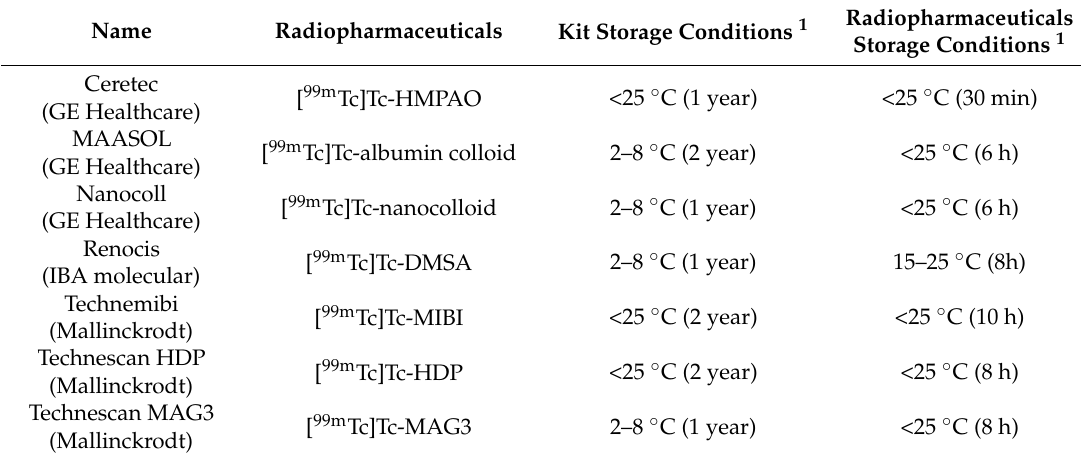
Table 1. Freeze-dried kits analyzed and the temperature required by the manufacturer for the storage of lyophilized kits and radiopharmaceutical preparations.